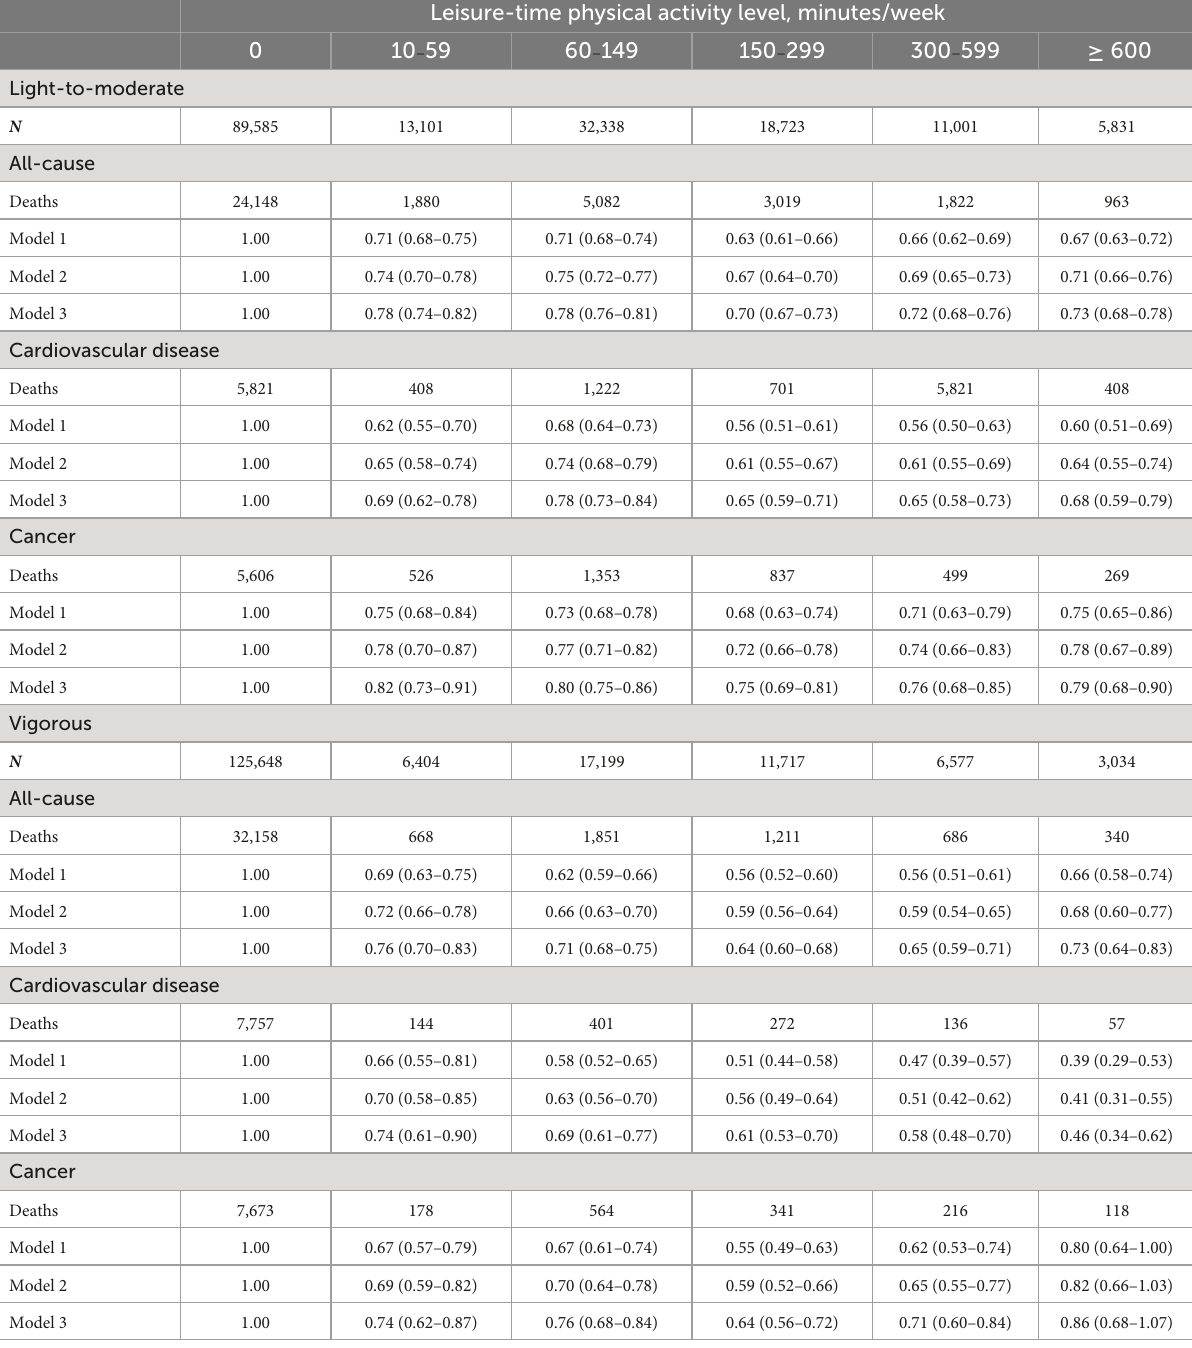
TABLE 3 Association between leisure-time physical activity level and all-cause and cause-specific mortality by the intensity of physical